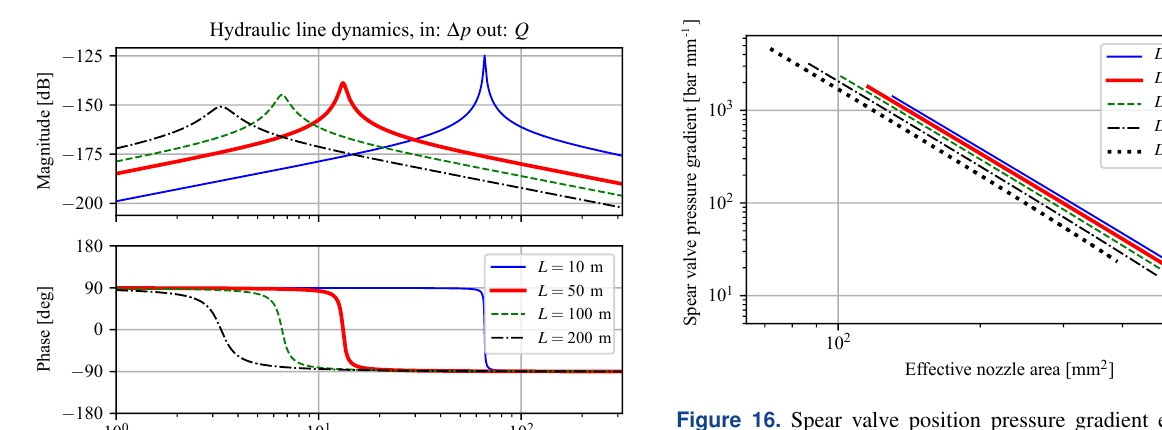
Figure 16. Spear valve position pressure gradient evaluated for different nozzle head diameters at a range of effective nozzle ar- eas. The pressure sensitivity is higher for larger nozzle diameters at equal effective areas. Results are presented in a double logarithmic